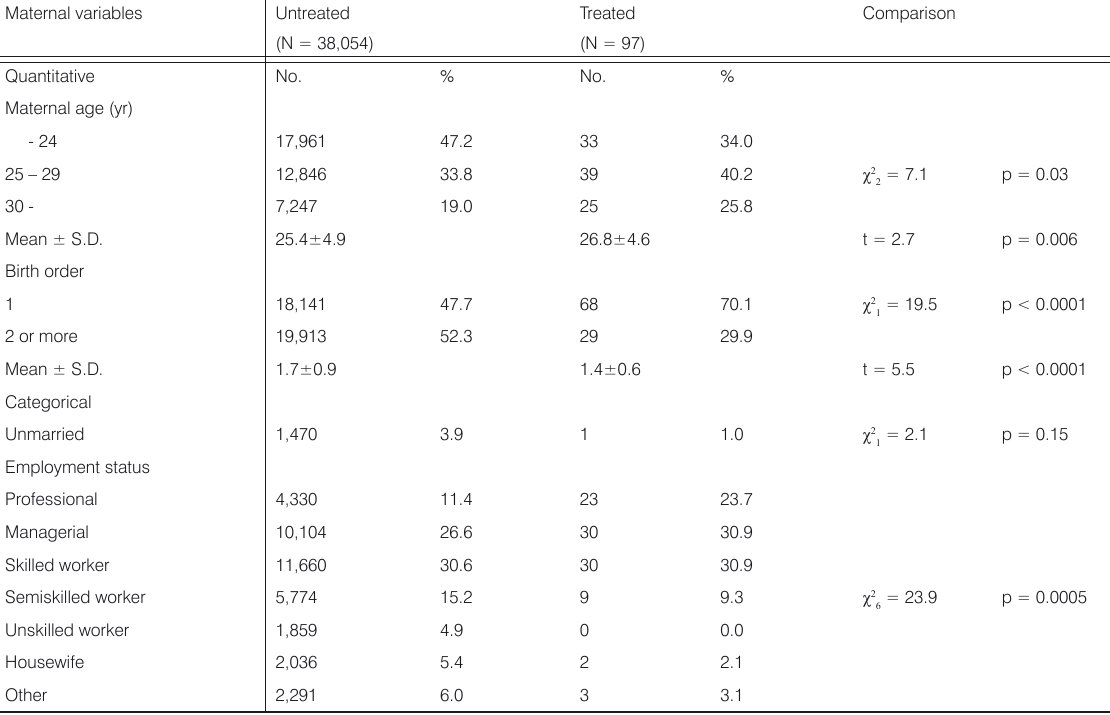
Table 1. Characteristics of mothers with or without HCG